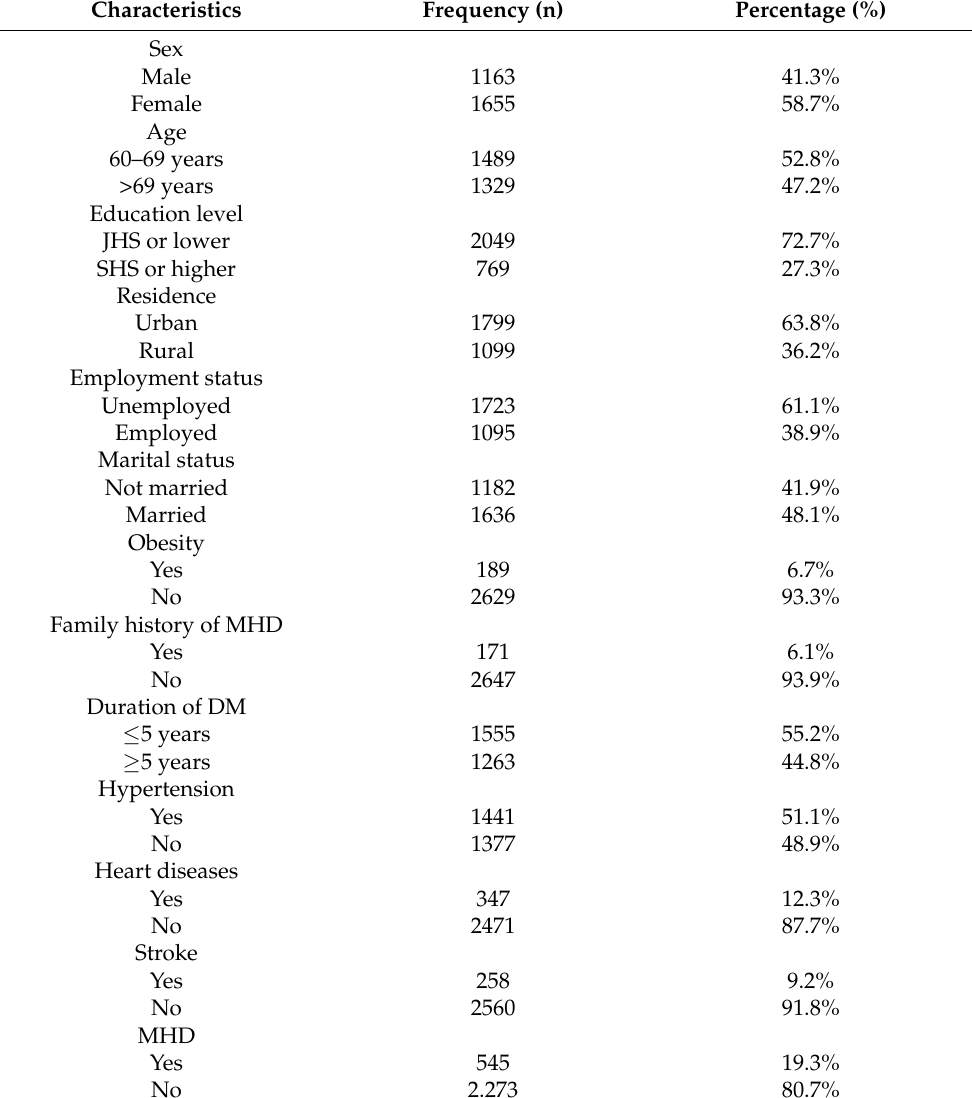
Table 1. Subjects’